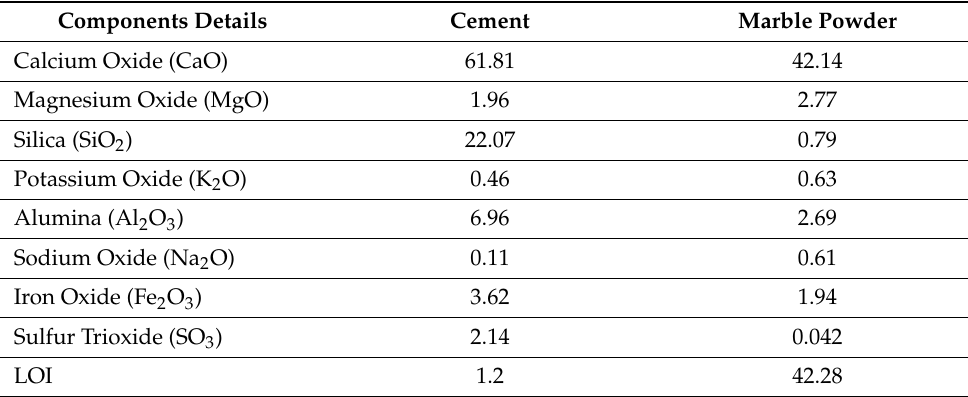
Table 2. Chemical composition of cement and marble powder.